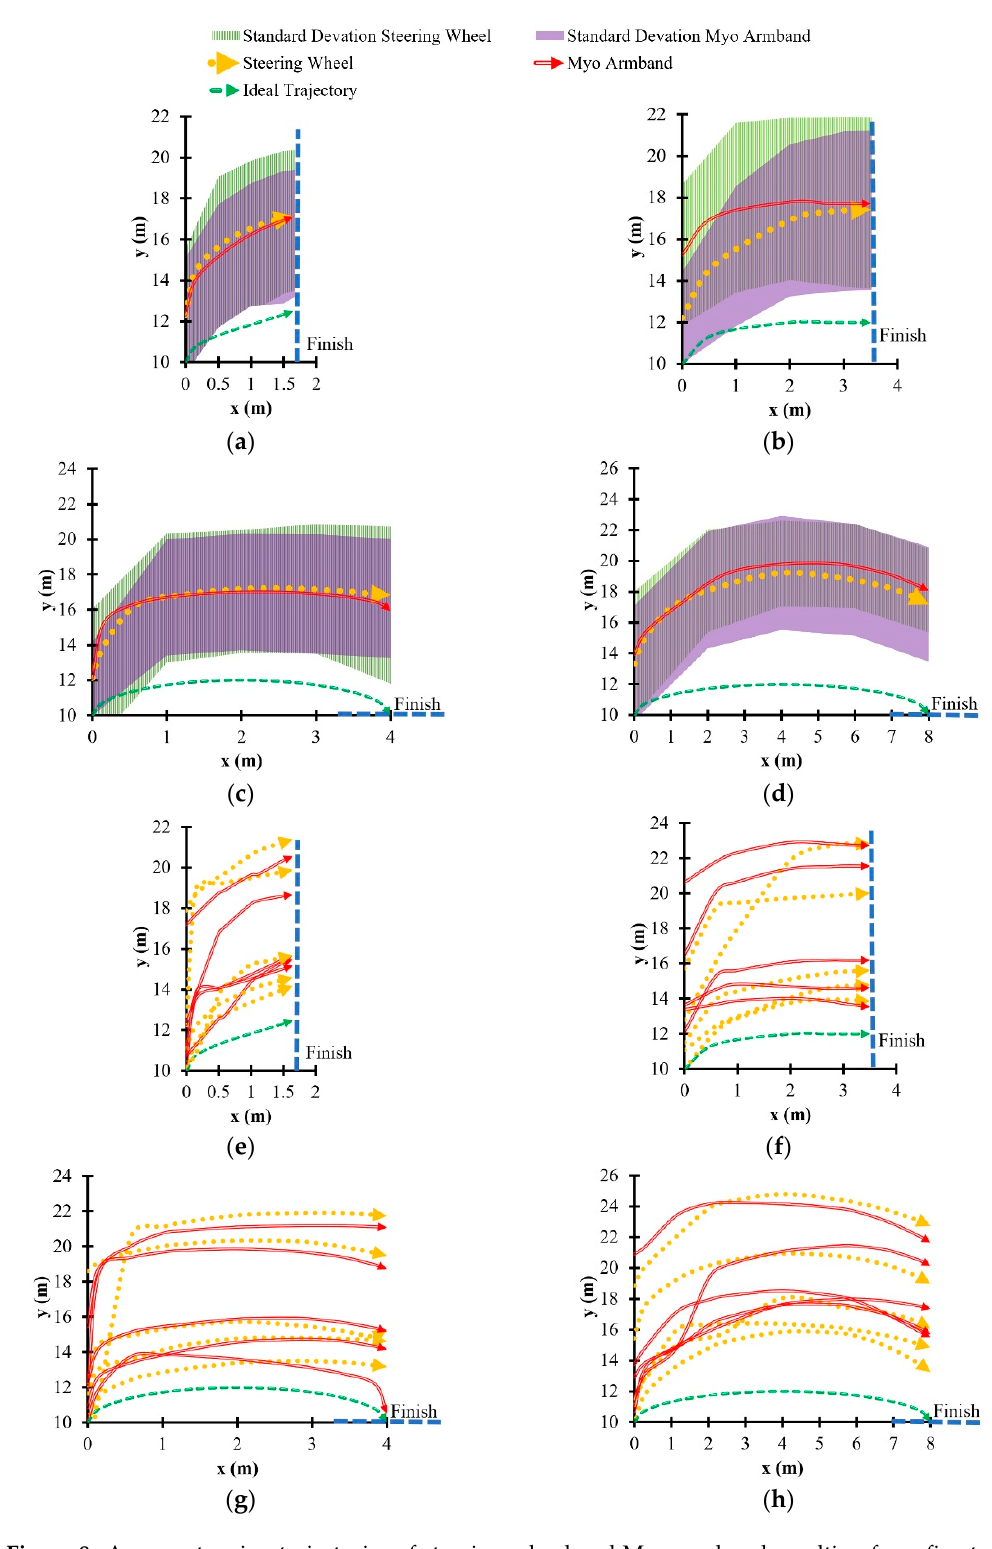
Figure 8. Average turning trajectories of steering wheel and Myo armband resulting from five test drivers performing: ( a ) 45° turn, ( b ) 90° turn, ( c ) narrow U-turn, and ( d ) wide U-turn. Individual turning trajectories for all five drivers shown for ( e ) 45° turn, ( f ) 90° turn, ( g ) narrow U-turn, and ( h ) wide U-turn.